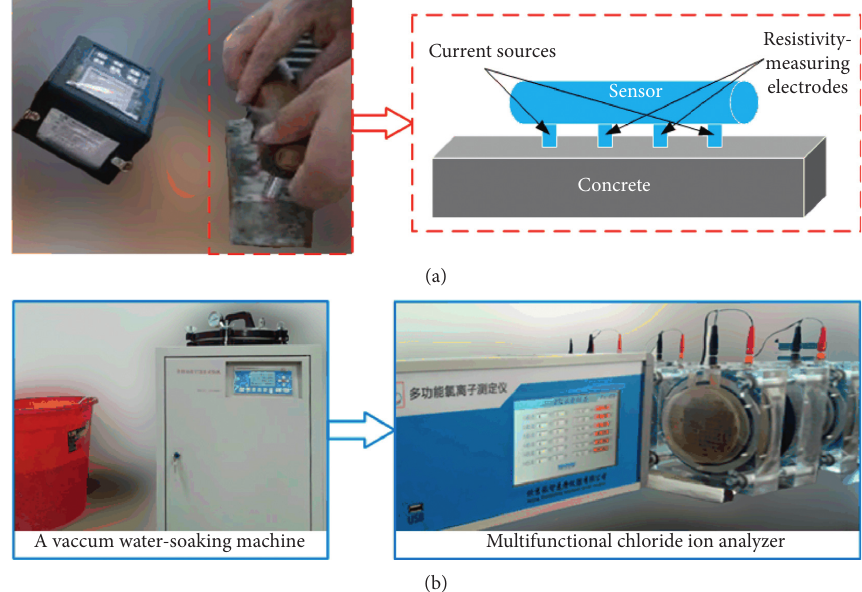
Figure 3: Surface resistivity test and rapid chloride permeability test of cement concretes. (a) Surface resistivity test. (b) Rapid chloride permeability test.